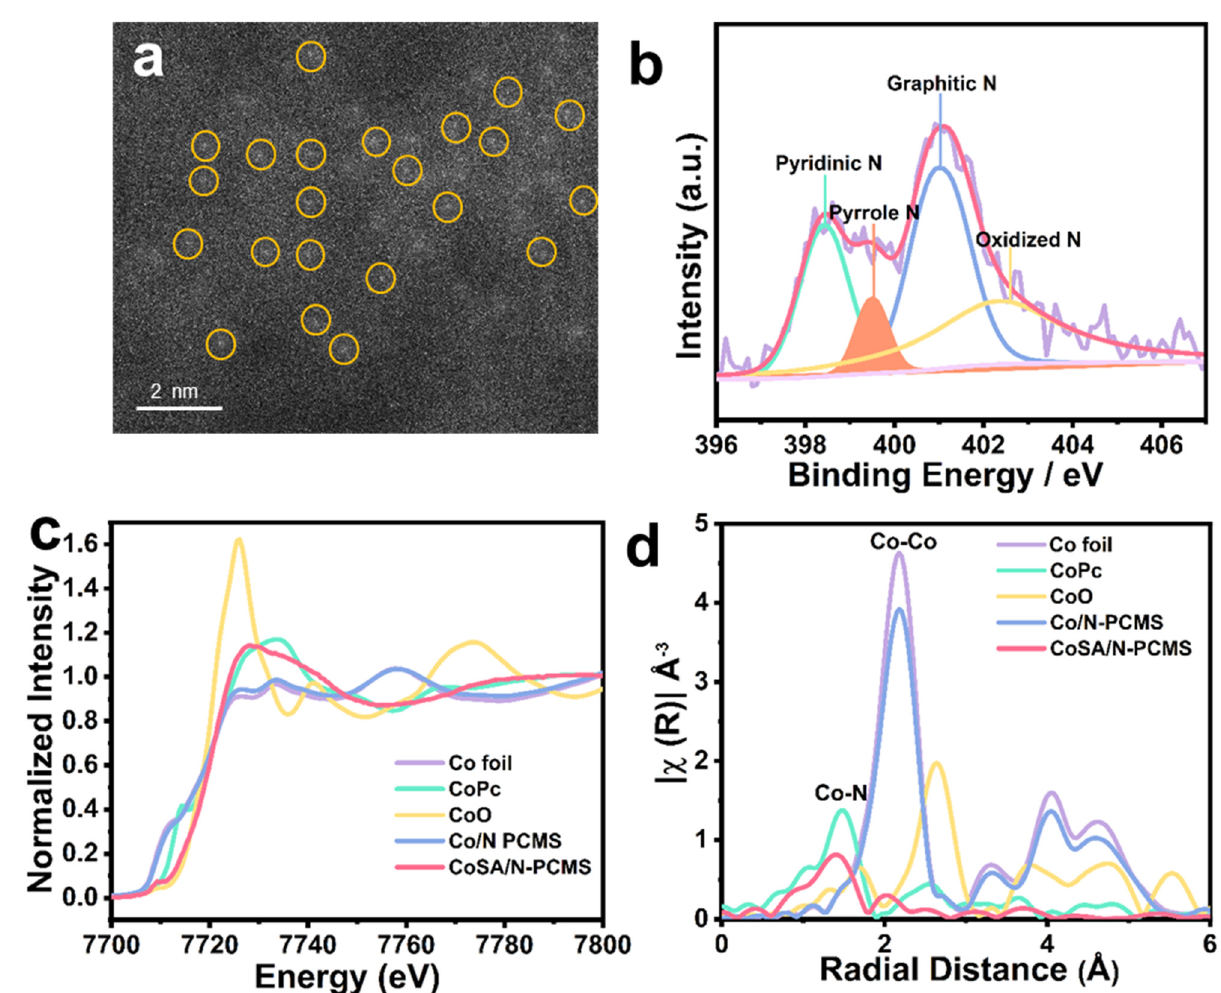
Figure 3. ( a ) HAADF-STEM image of CoSA/N − PCMS with atomically dispersed Co atoms partially circled. ( b ) N 1 s XPS high-resolution spectrum of CoSA/N − PCMS. ( c ) XANES spectra and ( d ) FT-EXAFS spectra of CoSA/N − PCMS and reference samples at the Co K-edge.